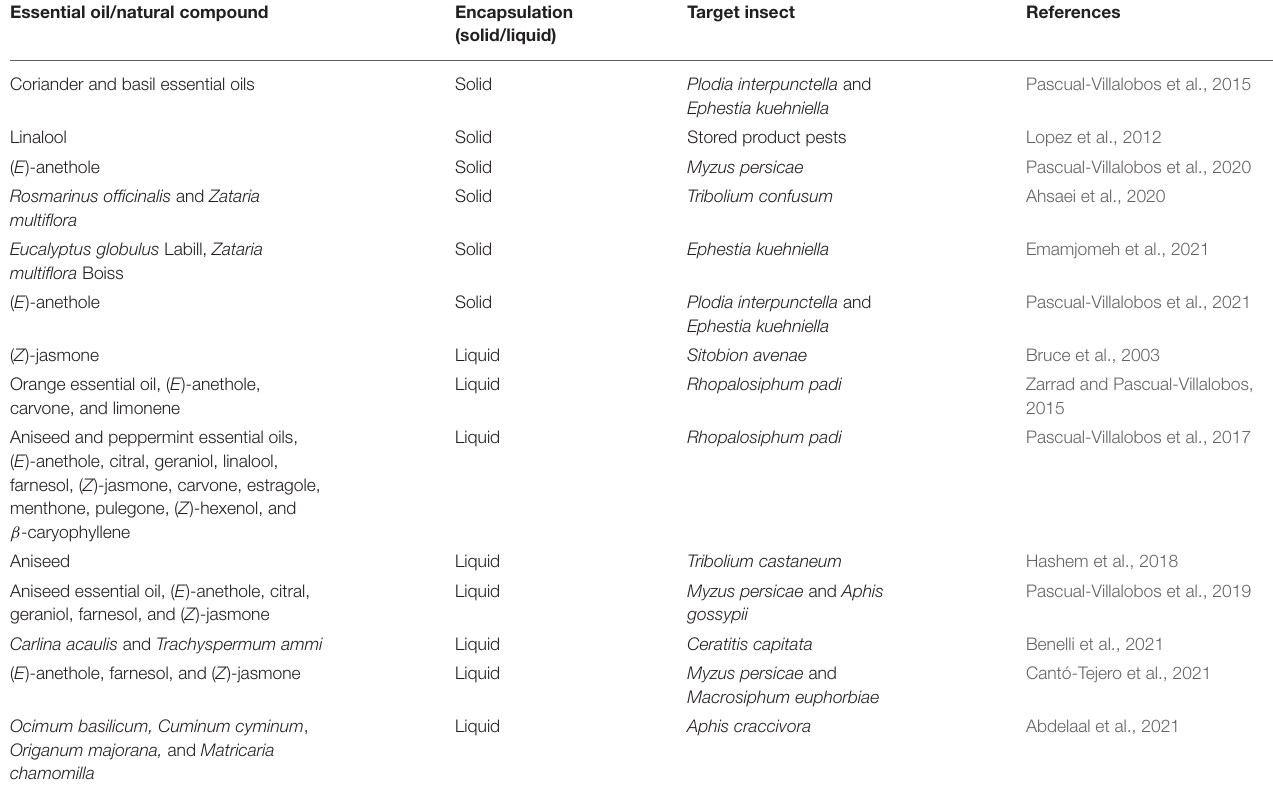
TABLE 1 | Recent research in the development of essential oil formulations (solid or liquid) against